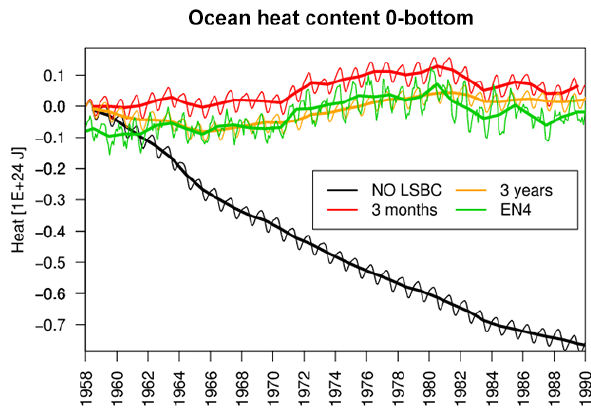
Figure 3. Background-error standard deviation temporal inflation (coefficient α ( t ) in Eq. 4). Thin lines refer to monthly means and thick lines to yearly means. Dashed black line corresponds to the long-term mean of α ( t ), while the dashed red line to the value of 1, i.e. the reference value before the application of the inflation.